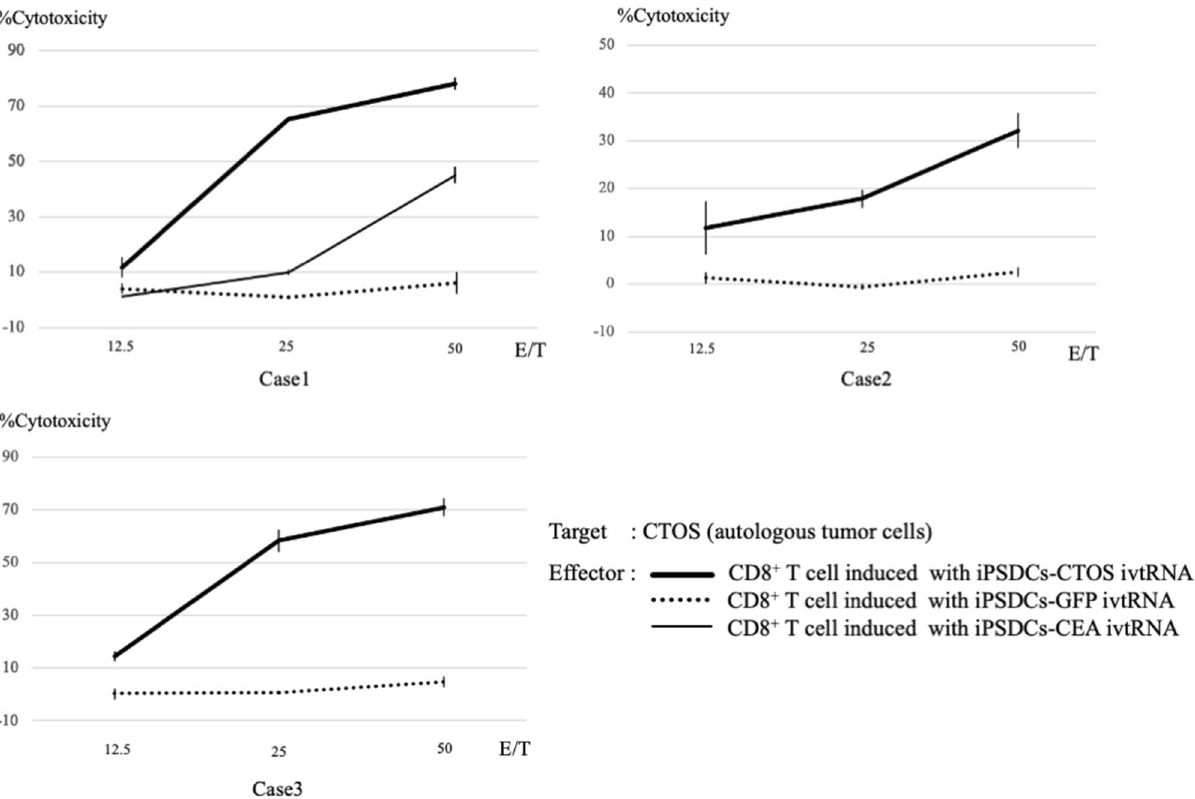
Figure 4. Cytotoxic activity of CTLs generated from iPSDCs-ivtRNA. CD8 + cytotoxic T cells were sorted using an autoMACS Pro Separator after three cycles of stimulation of autologous peripheral blood mononuclear cells, and their cytotoxic activity was tested using a 4-h 51 Cr release assay. The thick black line, dotted line, and thin black line represent the cytotoxic activity of CD8 + T cell induced with iPSDCs-CTOS ivtRNA, with iPSDCs- GFP ivtRNA, and with iPSDCs-CEA ivtRNA,